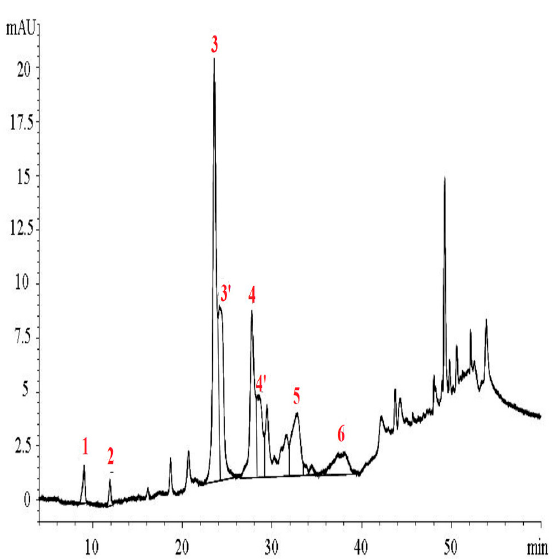
Figure 3. Profile at 278 nm of S-26 VOO PF using HPLC-DAD (protocol D) (peak numbers: 1: Htyr, 2: Tyr, 3: Decarboxymethyl oleuropein aglycone, dialdehyde form, 3 (cid:48) : Other structure of decarboxymethyl oleuropein aglycone, dialdehyde form, 4: Decarboxymethyl ligstroside aglycone, dialdehyde form, 4 (cid:48) : Other structure decarboxymethyl ligstroside aglycone, dialdehyde form, 5: Oleuropein aglycone, 6: Ligstroside aglycone). Table 4. Total (free and bound forms) Htyr and Tyr content (mg / 20 g oil) of VOO samples according to protocol